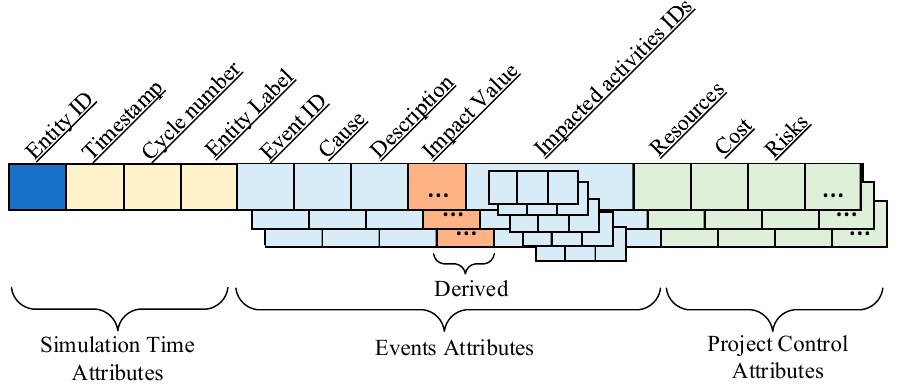
Figure 2. Entity information model (EIM).